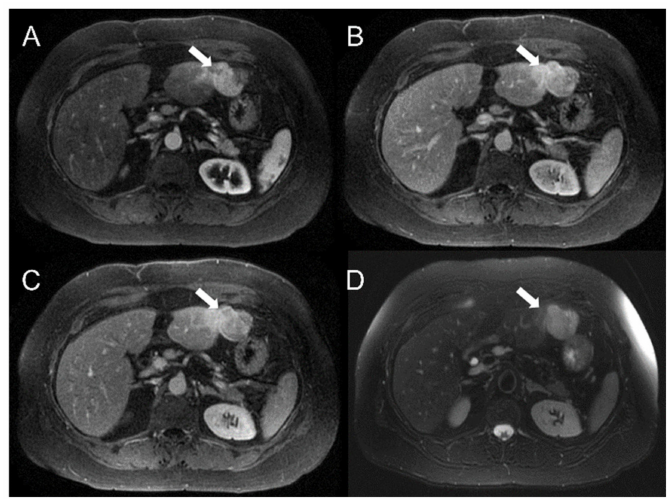
Figure 4. Poorly differentiated HCC (G3) in the left hepatic lobe of a 57-year-old white female. Results showed hyperintense HCC on axial dynamic acquisition ( A – C ) and on fat-suppressed axial T2-weighted sequence ( D ) (white